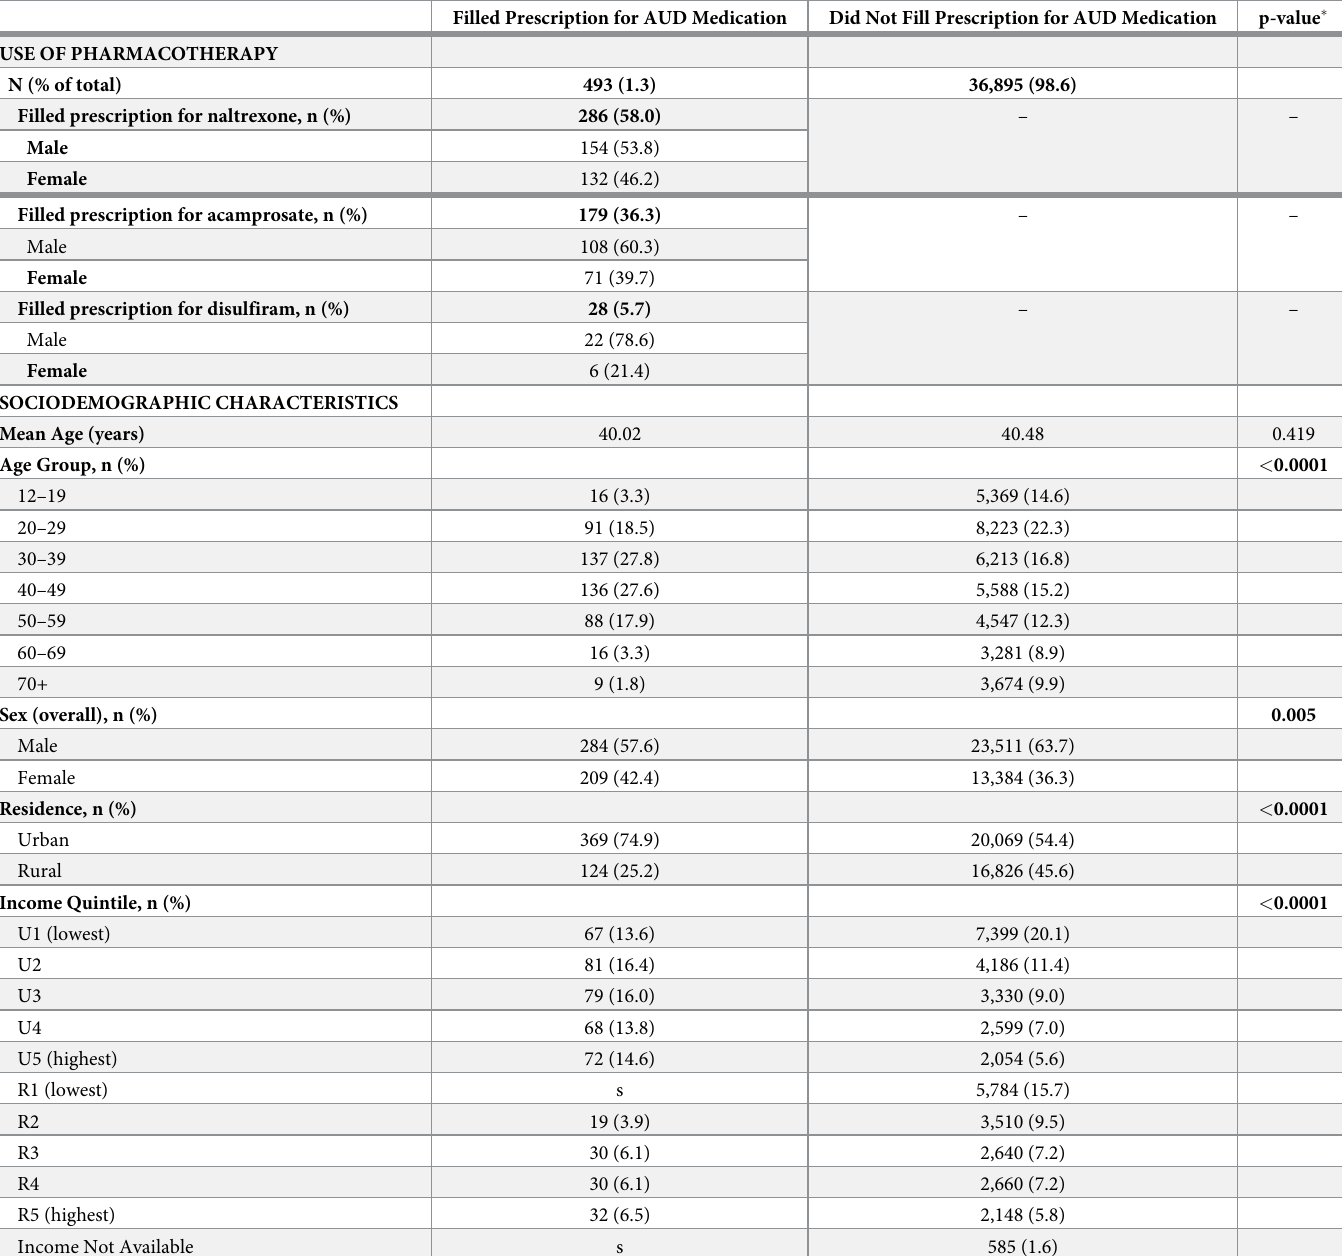
Table 1. Sociodemographic characteristics of Manitobans with alcohol use disorder. Filled Prescription for AUD